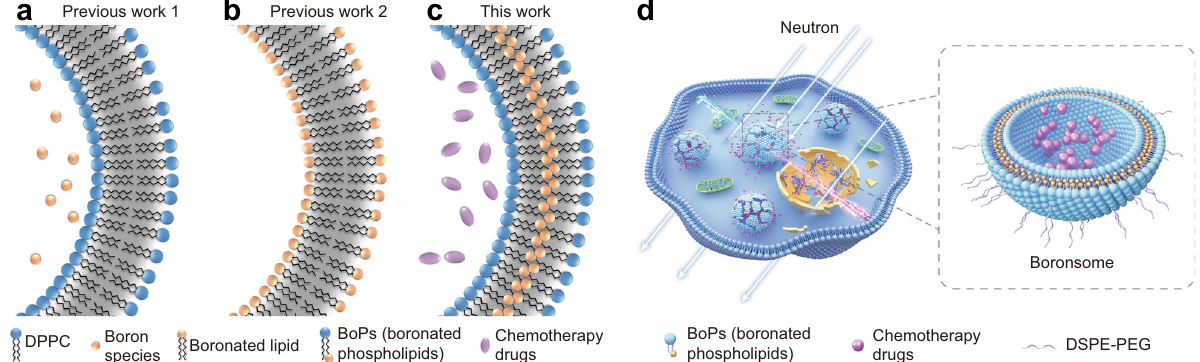
Fig. 1 Schematic illustration of boronated liposomes for BNCT. a – c Formulations of previous boronated liposomes ( a , b ) and boronated liposomes in this work (boronsomes, ( c ). d Boronsomes emit high-energy particles when irradiated by neutrons and release chemotherapy drugs sequentially to kill cancer